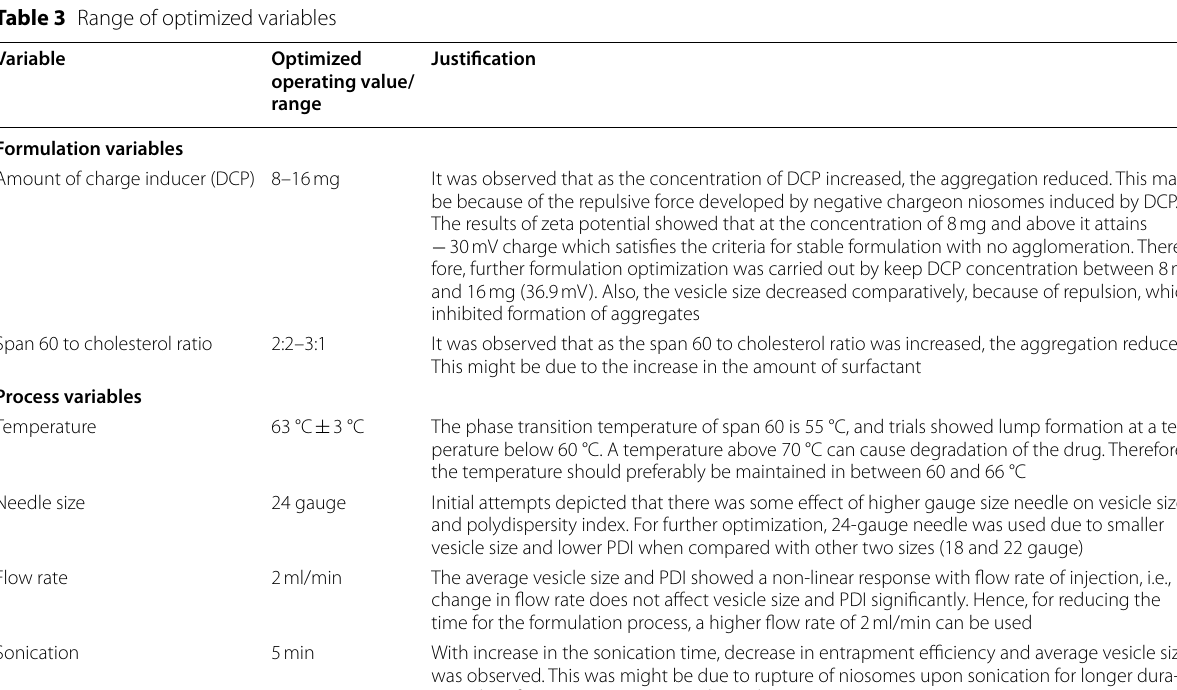
Table 4 Design matrix and response for 2 3 factorial design batches [ X —drug to span 60 molar ratio, X 1